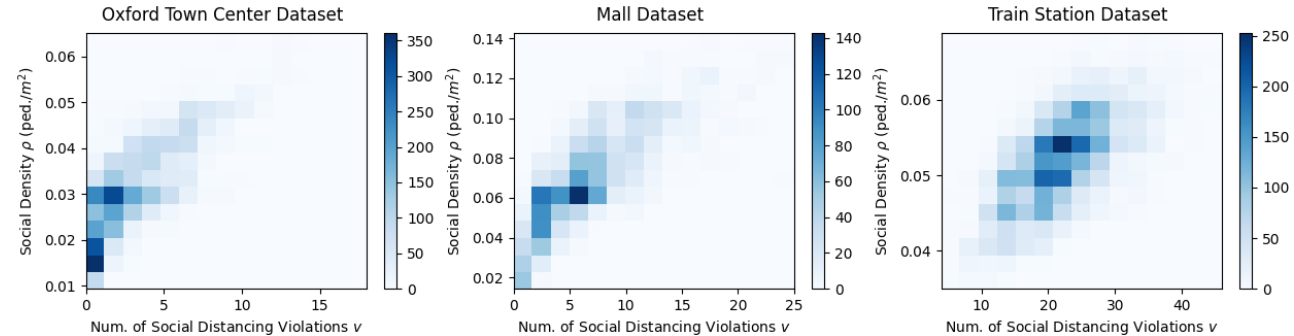
Figure 5. Two-dimensional histograms of the social density ρ versus the number of social distancing violations v . From the histograms we can see a linear relationship with positive